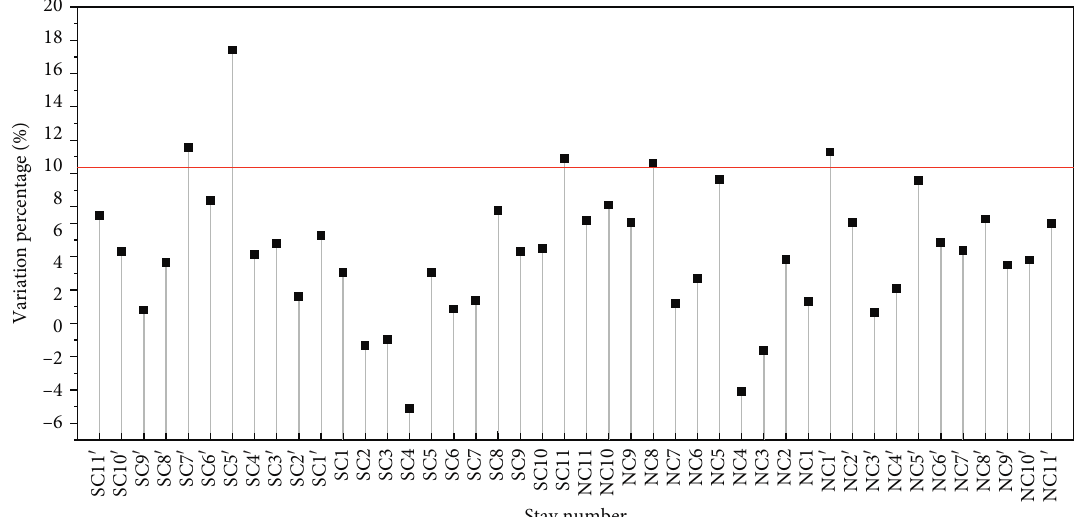
Figure 7: Variation percentages of cable forces measured before replacement relative to those in the originally completed